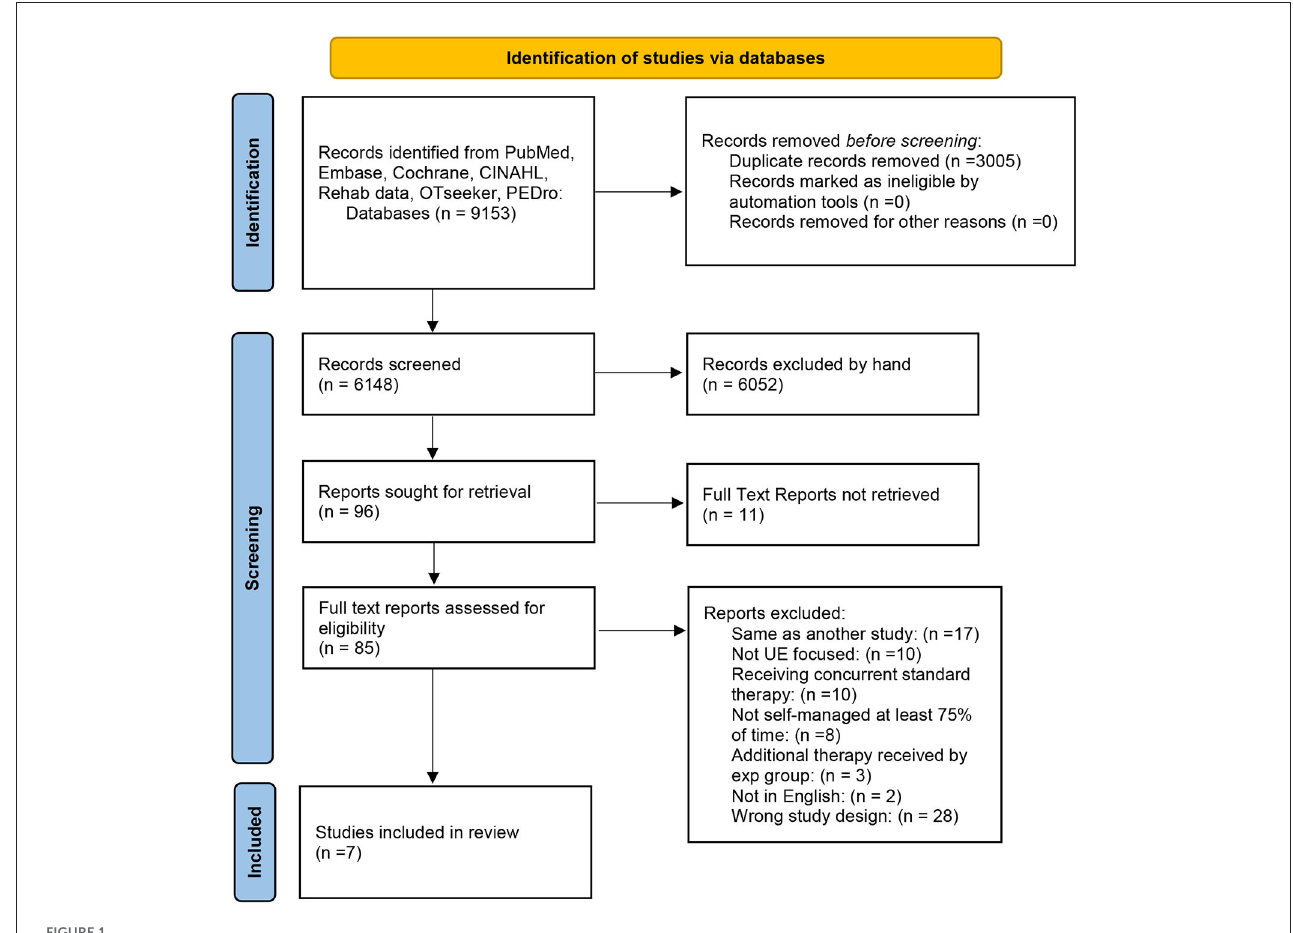
FIGURE1 Prisma flow